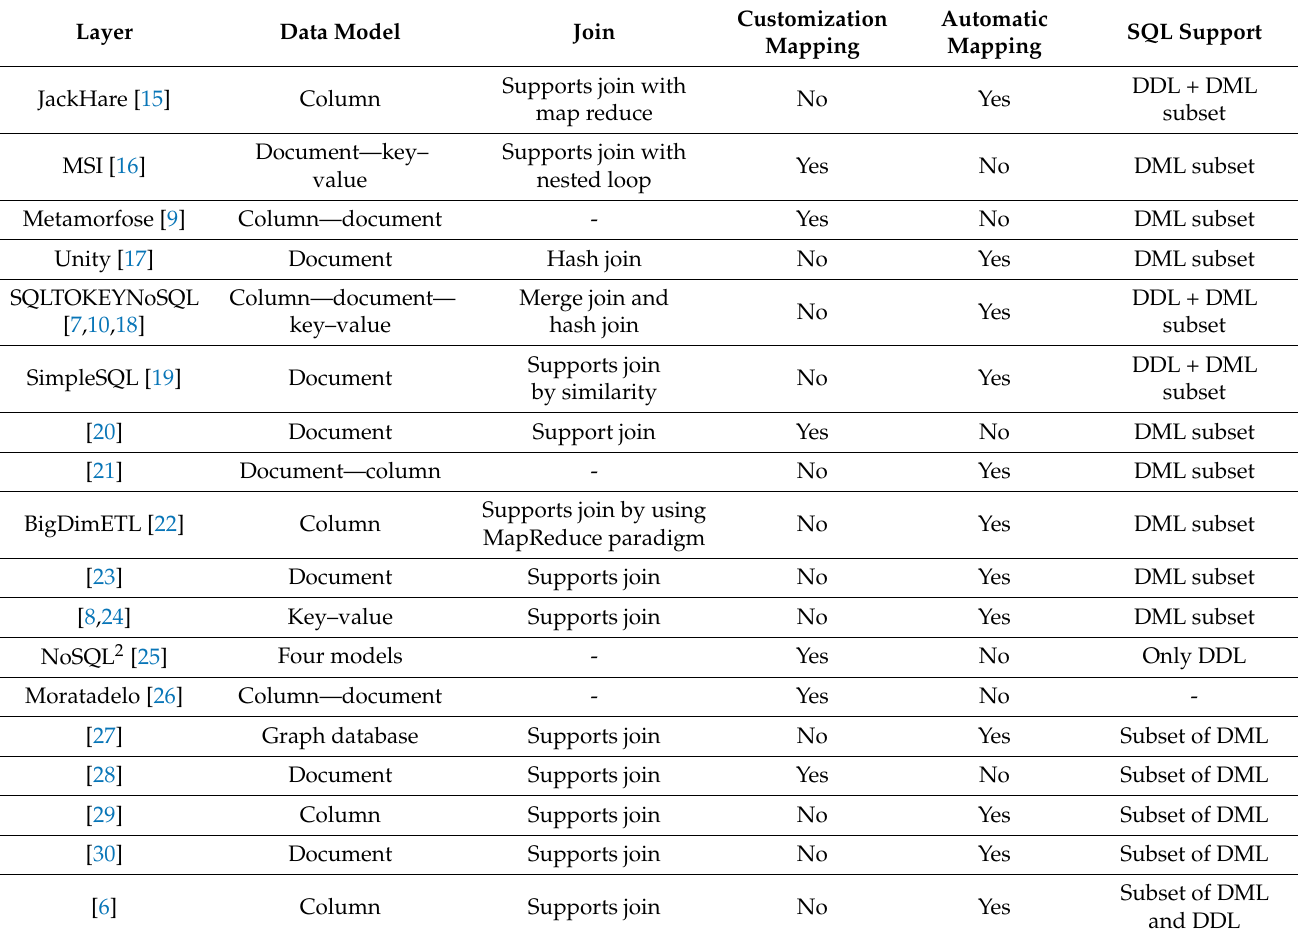
Table 1. Comparison between the proposed layers of previous